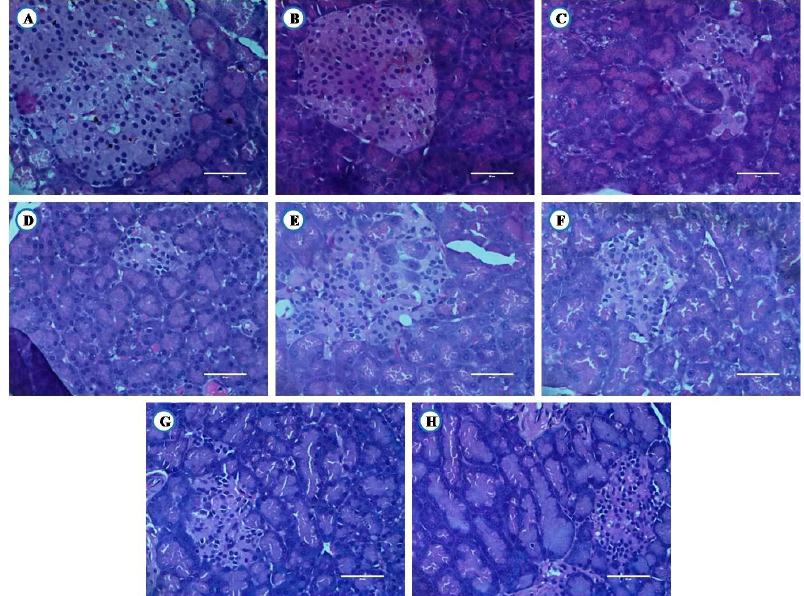
Figure 13. Histological examination of pancreas (Scale bar 50 µ m). ( A ) Healthy control, ( B ) High fat diet control, ( C ) Diabetic control, ( D ) Glibenclamide control, ( E ) Statin control, ( F ) Glibenclamide statin control, ( G ) Flax oil (500 mg/kg), ( H ) Flax oil (500 mg/kg).